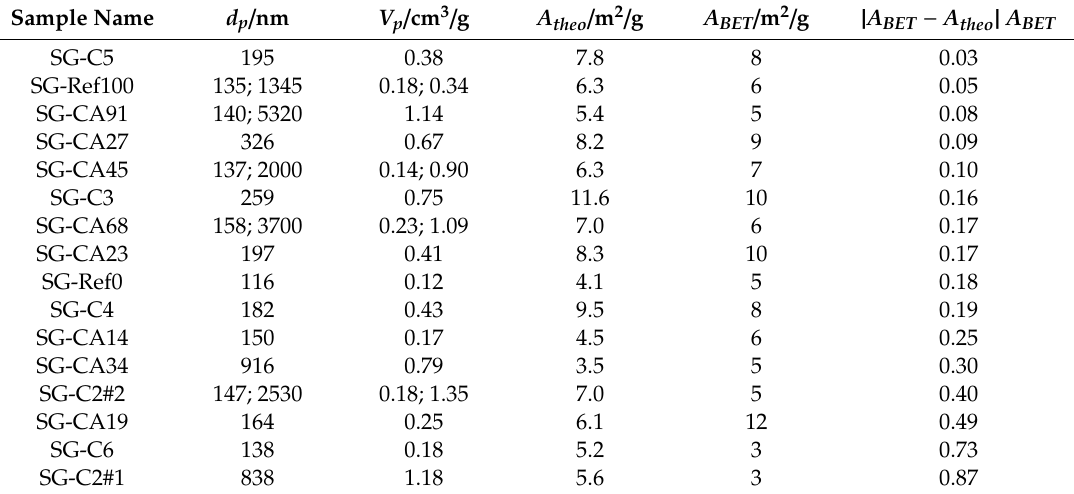
Table 3. Exemplary specific surface areas as a function of d p,mod and V p , as obtained by mercury intrusion, and corresponding A BET calculated from nitrogen sorption. Sample names are explained in Section 5.1 below. However, their signification is not relevant for this consideration. Samples appear in order of the deviation ratio | A BET − A theo |/ A BET